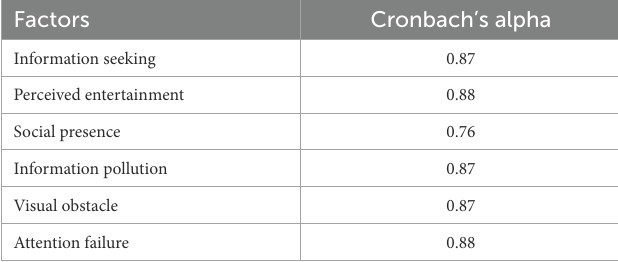
TABLE 7 Cronbach’s alpha test